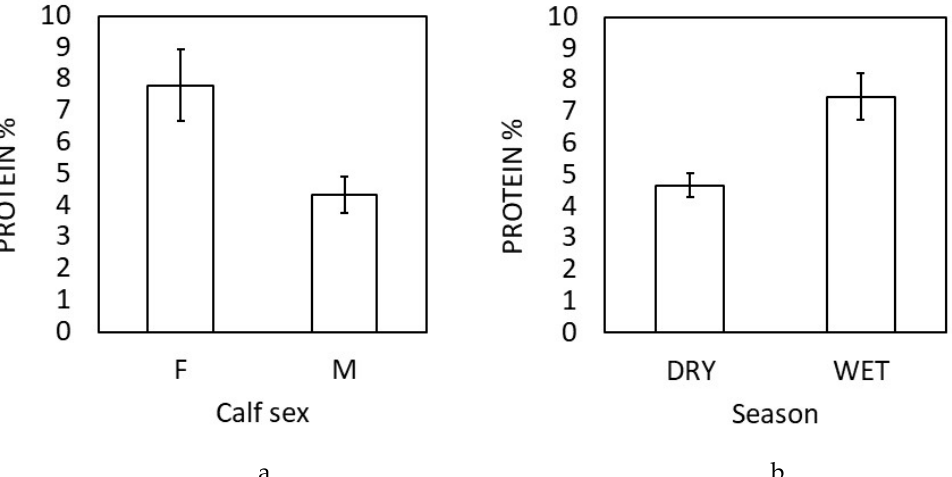
Figure 2. Sex and seasonal differences in protein composition of elephant milk. Protein composition was higher in milk of mothers with female calves compared to male calves ( a ) and protein content in milk was higher during the wet season compared to the cold, dry season in Myanmar ( b ). Figures show standard errors (error bars) and predicted means (bars).